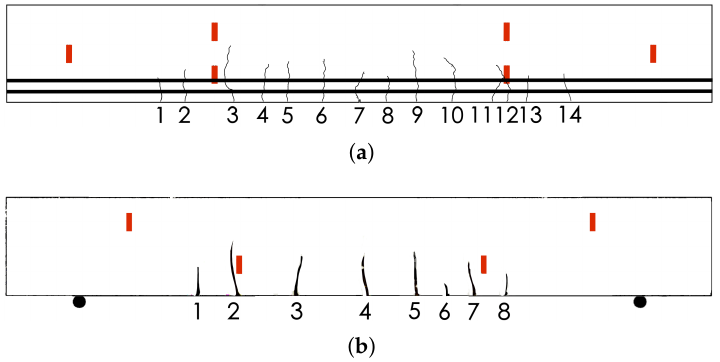
Figure 9. Cracks map of beam at ( a ) BAM and at ( b )